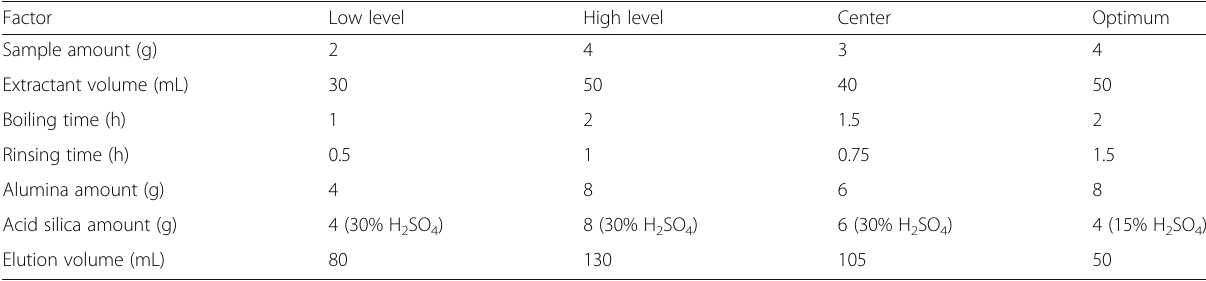
Table 1 Experimental parameters of extraction and purification steps, factor levels tested in the factorial design, and optimum values for